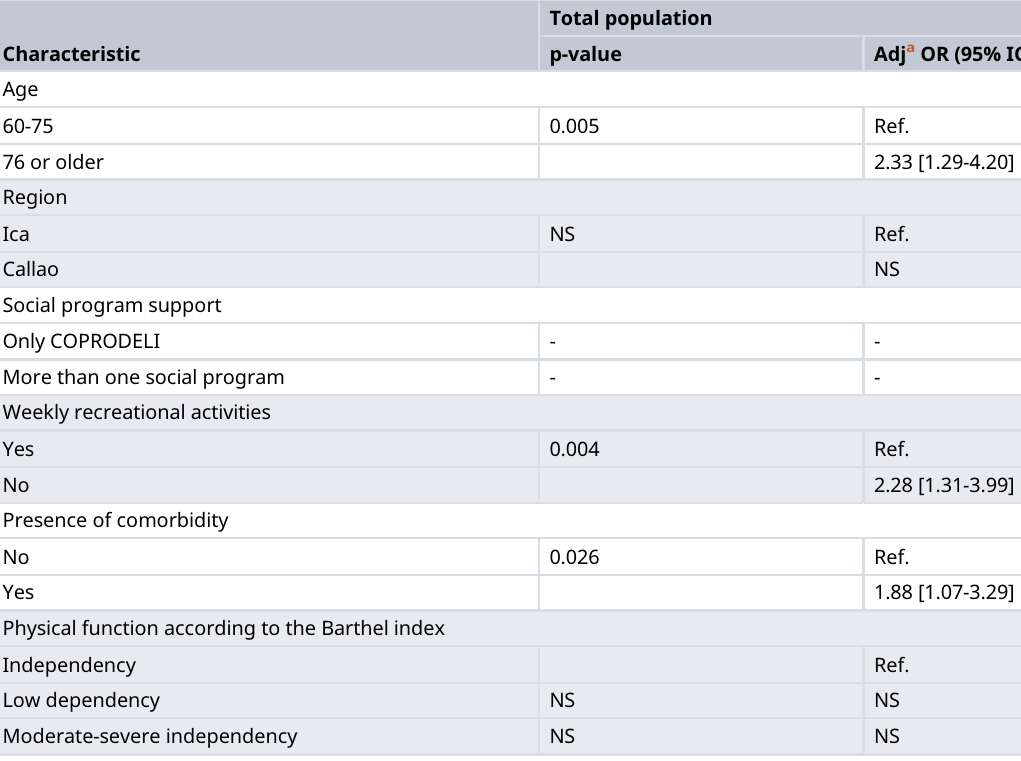
Table 3. Logistic regression analysis of depression in older adults enrolled in the Social Program-COPRODELI during the COVID-19 Pandemic, Peru.